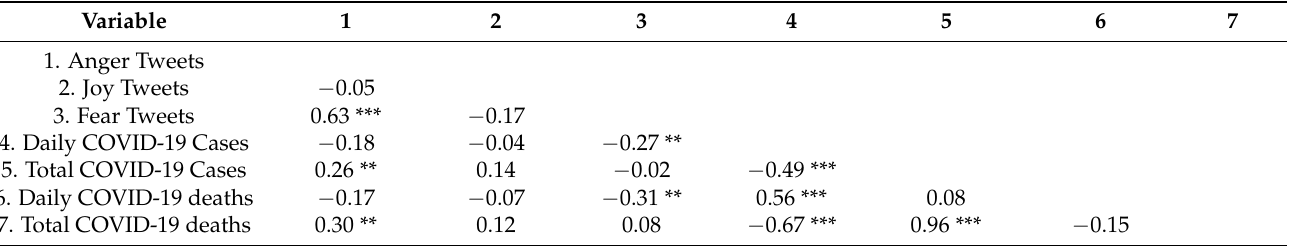
Table A2. Venice Pearson’s correlation coefficient